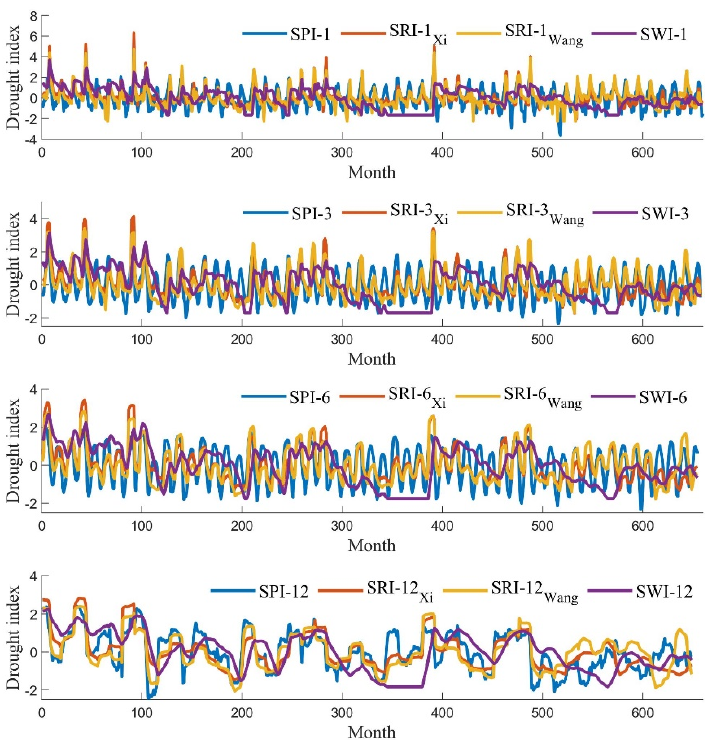
Figure 4. Results for the SPI, SRI Xi , SRI Wan , and SWI at different timescales from 1956 to 2010. Next, the drought characteristics SPI, SRI Xi , SRI Wang , and SWI calculated for different timescales were analyzed and plotted (Figure 5).